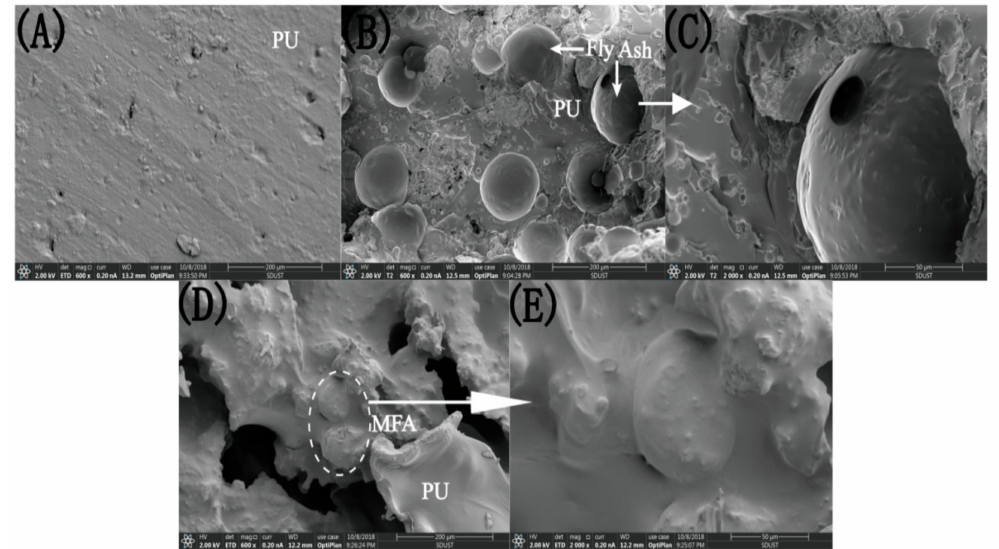
Figure 8. The SEM micrographs of fracture surface of ( A ) PU, ( B ) and ( C ) PU / MFA-0.0 wt. %, ( D ) and ( E ) PU / MFA-2.5 wt. % specimens after fracture toughness test.